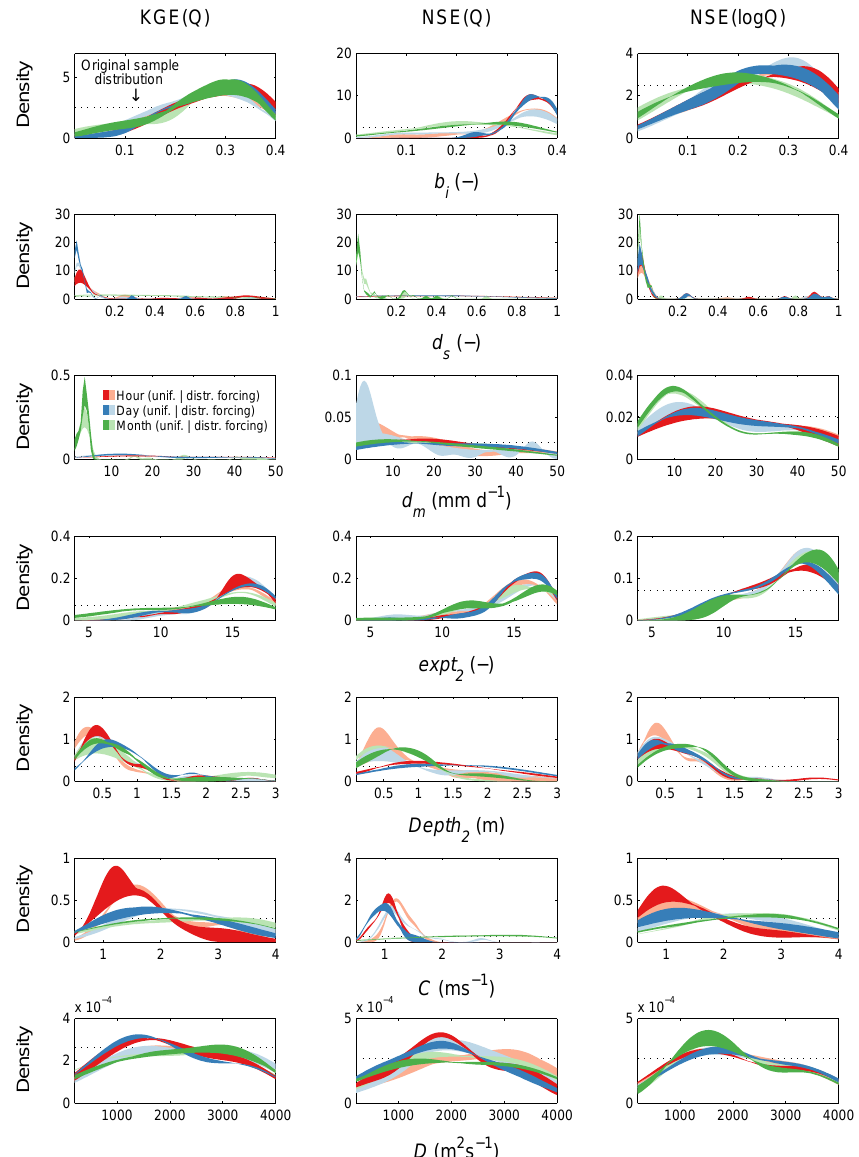
Figure 8. Distribution of the sampled parameters for the behavioural sets, fitted with a kernel density. The width of the line indicates the variation in distribution between the different spatial resolutions. The left column is based on KGE( Q ), the middle column on NSE( Q ) and the right column on NSE(log Q